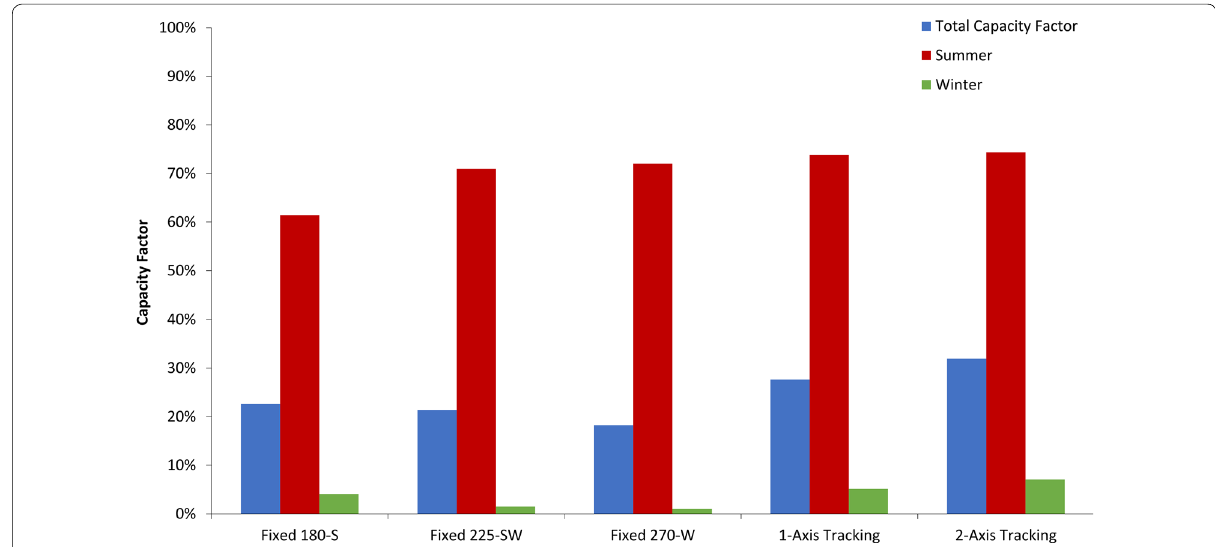
Fig. 8 Firm capacities at 87.5% for the 60 MW combined farms for WT wind site Buffalo Gap and various solar array configurations at the Roserock solar site. This metric shows the change in guaranteed production for WT wind and solar sites with different